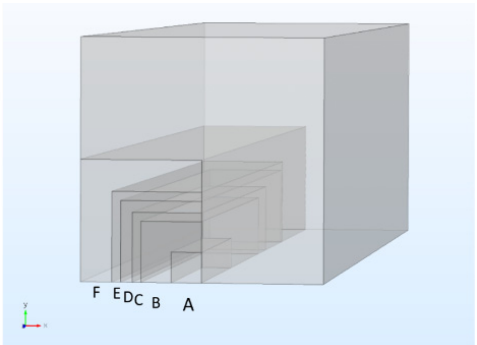
Table 2. Size information of cut-outs.